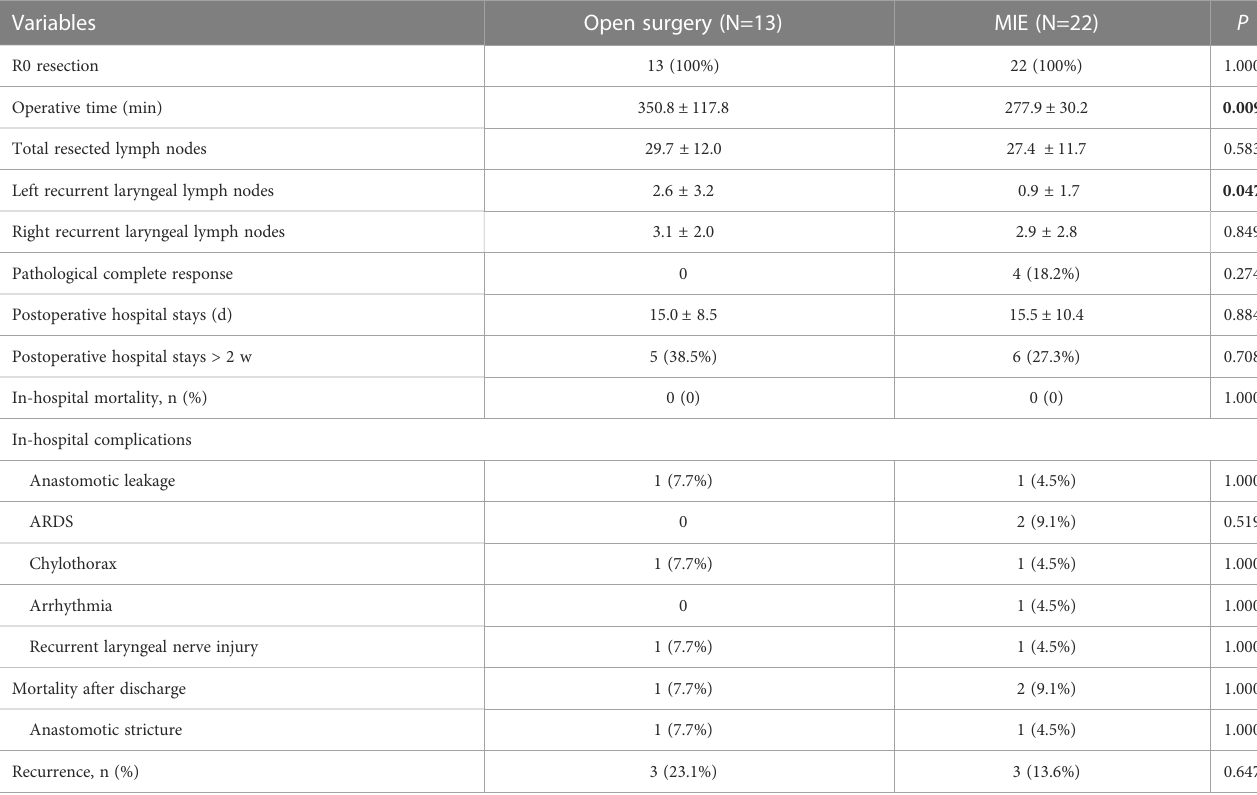
TABLE 4 Comparison of postoperative outcomes between open surgery and minimally invasive approaches. Variables